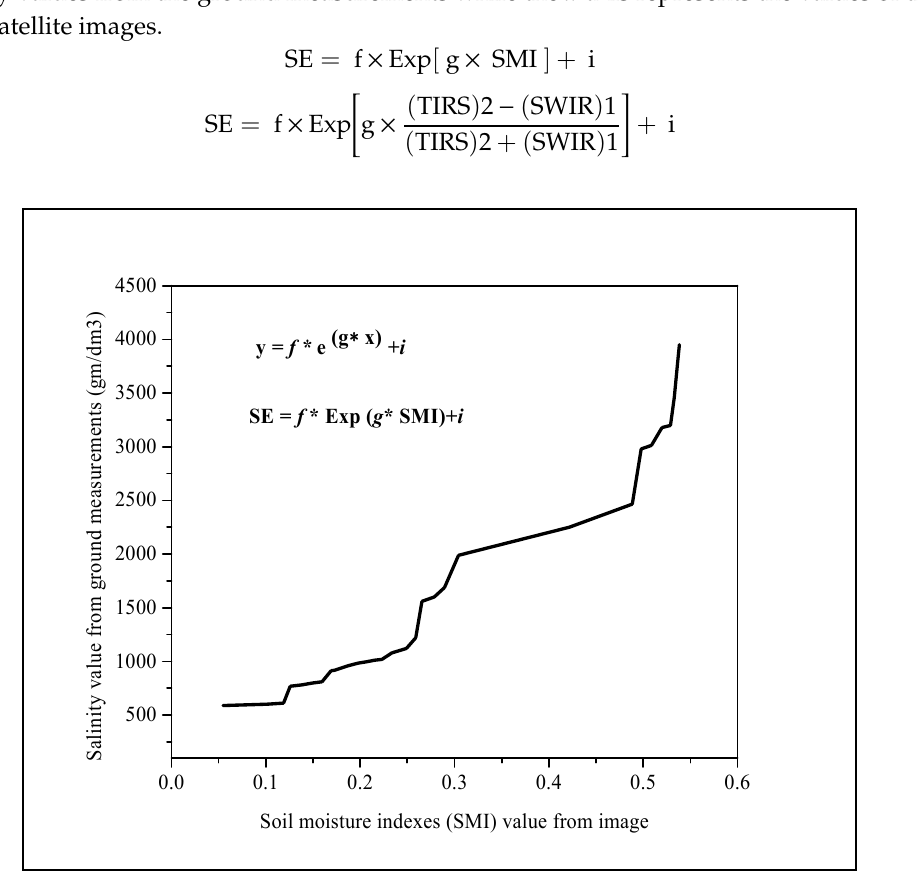
Figure 6. Salinity equation (SE) based on the relationship between soil moisture index values of the satellite images and salinity values from the ground measurements.